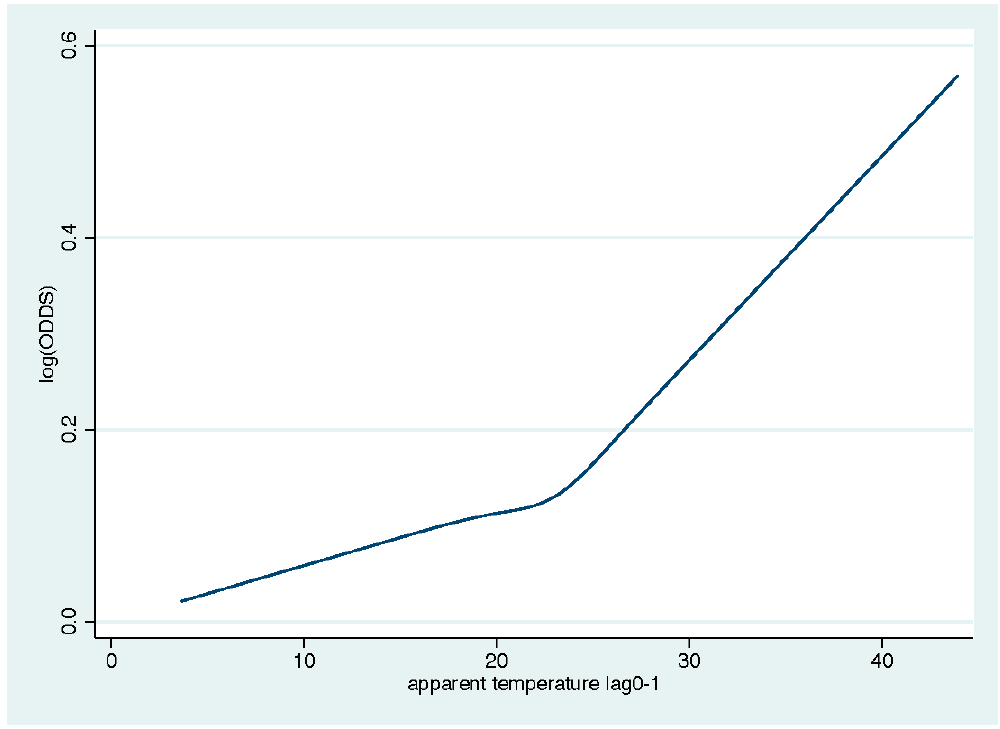
Figure 1. Prediction of death in the study populations according to apparent temperature at lag 0–1.